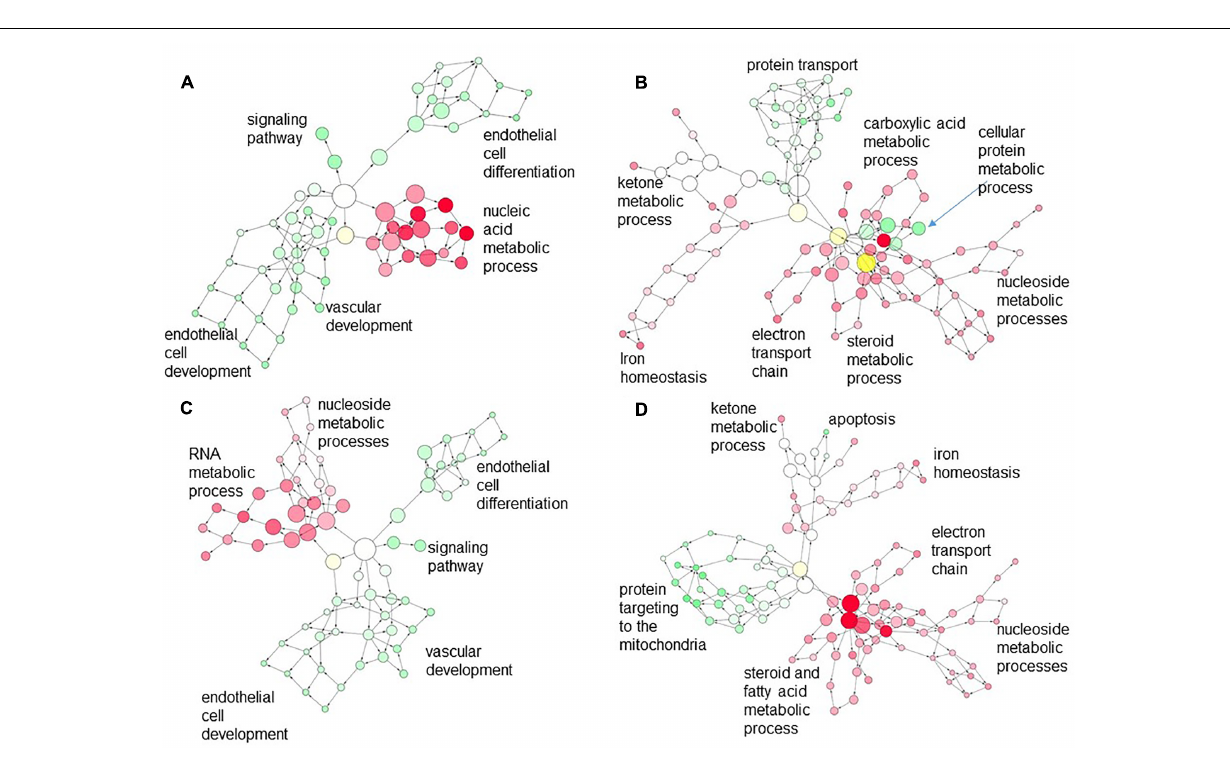
Frontiers in Physiology |